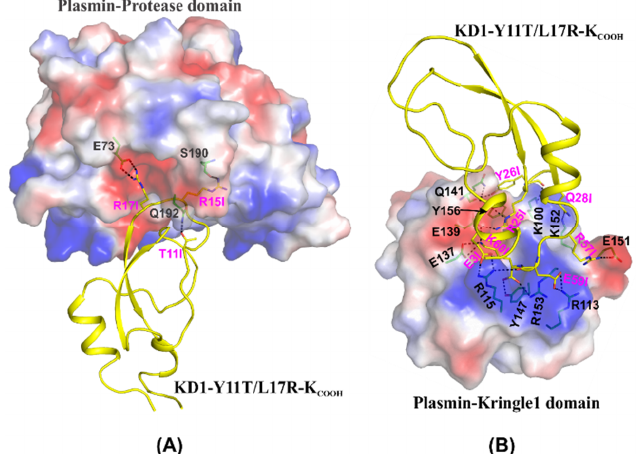
Figure 12. Modeled complexes of KD1-Y11T/L17R-K COOH interaction with plasmin. ( A ) Modeled interactions of KD1-Y11T/L17R-K COOH with the plasmin protease domain. The electrostatic surface of the plasmin protease domain and a cartoon representation of the KD1-Y11T/L17R-K COOH (yellow) are depicted. The P1 (Arg15), P5 (Thr11) and P2′ (Arg17) residues of KD1-Y11T/L17R-K COOH interactions with plasmin are shown in stick representation. In the electrostatic surface, blue represents positive, red represents negative, and white represents neutral charge. ( B ) Modeled interaction of KD1- Y11T/L17R-K COOH with plasmin kringle domain. The electrostatic surface of the plasminogen kringle domain1 and a cartoon representation of the KD1-Y11T/L17R-K COOH (yellow) are depicted. The residues that form hydrogen bonds and salt bridges (shown as dashed lines) between the kringle domain and KD1-Y11T/L17R-K COOH are shown in stick representation. The carbon atoms are shown in green for the kringle domain and yellow for KD1-Y11T/L17R-K COOH . As in ( A ) oxygen atoms are shown in red and nitrogen atoms in blue. The KD1-Y11T/L17R-K COOH residues are labeled with the suffix I. In the electrostatic surface, blue represents positive, red represents negative, and white represents neutral charge.